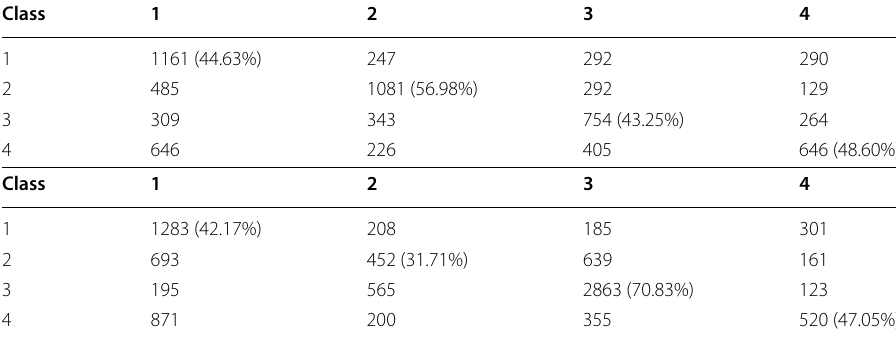
Table 2 Confusion matrices of participants 5 and 6 using KNN Class